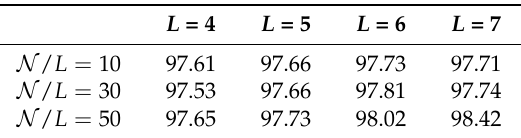
Table 4. Service guarantee rate (%).